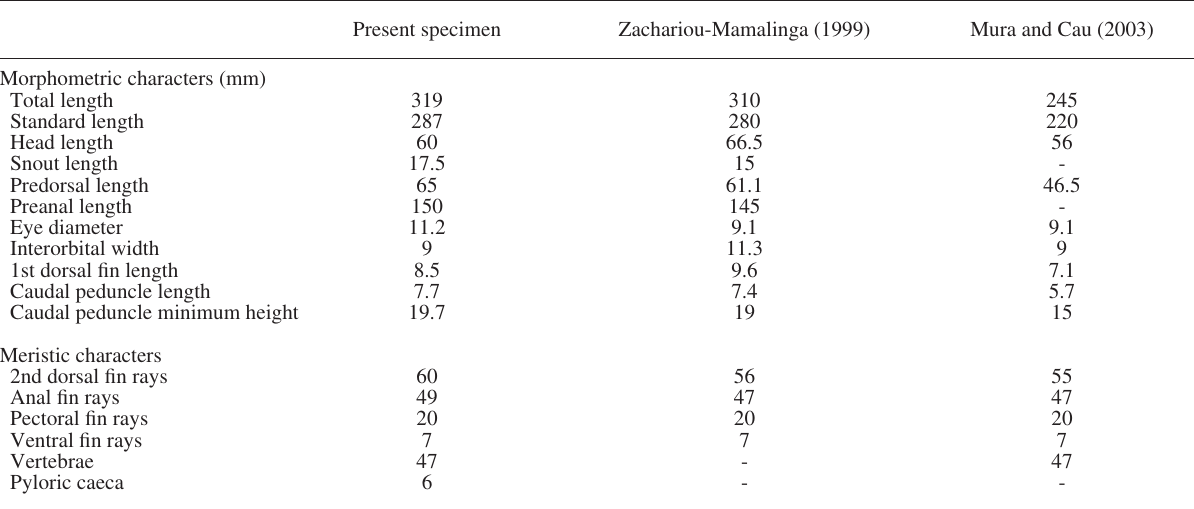
Table 1. – Morphometric and meristic data of Gaidropsarus granti specimens recorded in the Mediterranean